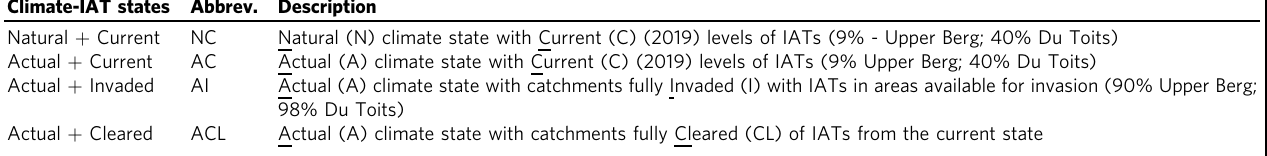
Table 1 A description of the climate-invasive alien tree states (climate-IAT states) for the Cape Town Drought, South Africa. Climate-IAT states Abbrev. Description